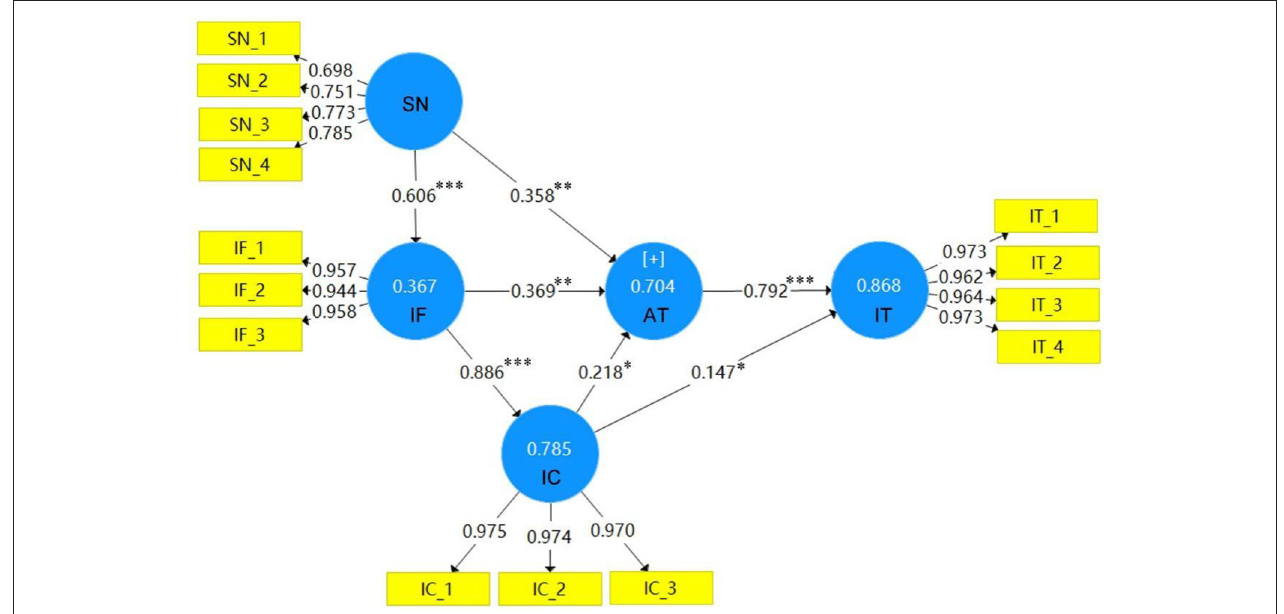
FIGURE 3 | Research model of hypothesis testing of loss framing. * p < 0.05, ** p < 0.01, *** p < 0.001.